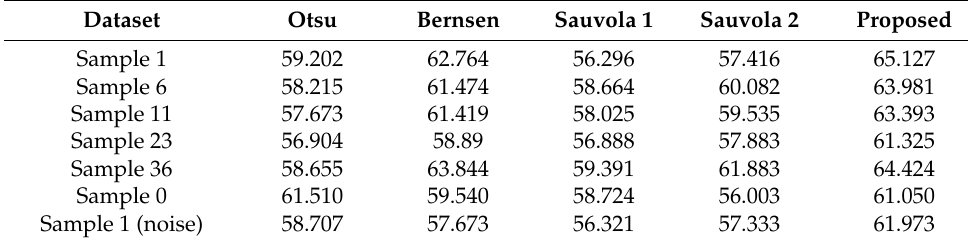
Table 2. Metric PSNR.